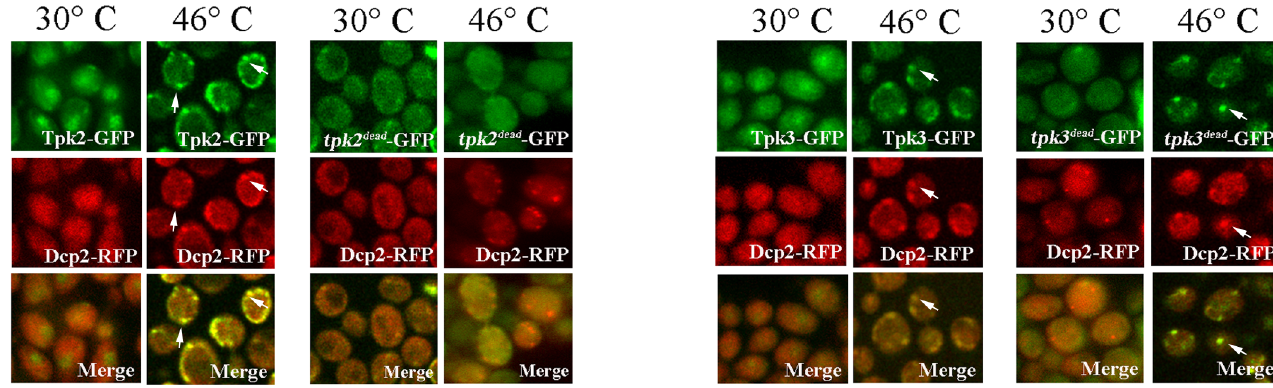
Fig 3. Characterization of kinase dead tpk2 and tpk3 granule localization evoked by severeheat stress. Cells co-expressing Tpk2-GFP, tpk2 dead -GFP, Tpk3-GFP or tpk3 dead -GFP and Dcp2-RFP were subjectedto severe heat stress as describedin Fig 2A. Co-localization was determinedby confocalmicroscopy. Arrows indicateTpk-GFP granularlocalization and merge.